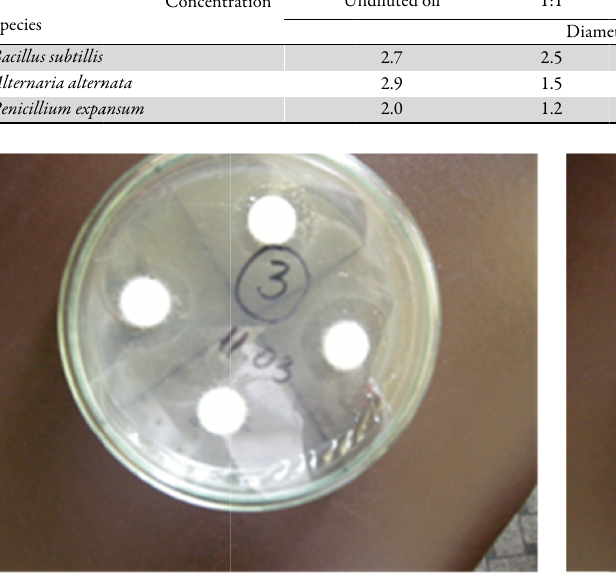
Fig. 1. Diameters of the inhibiting zones at Bacillus subtillis